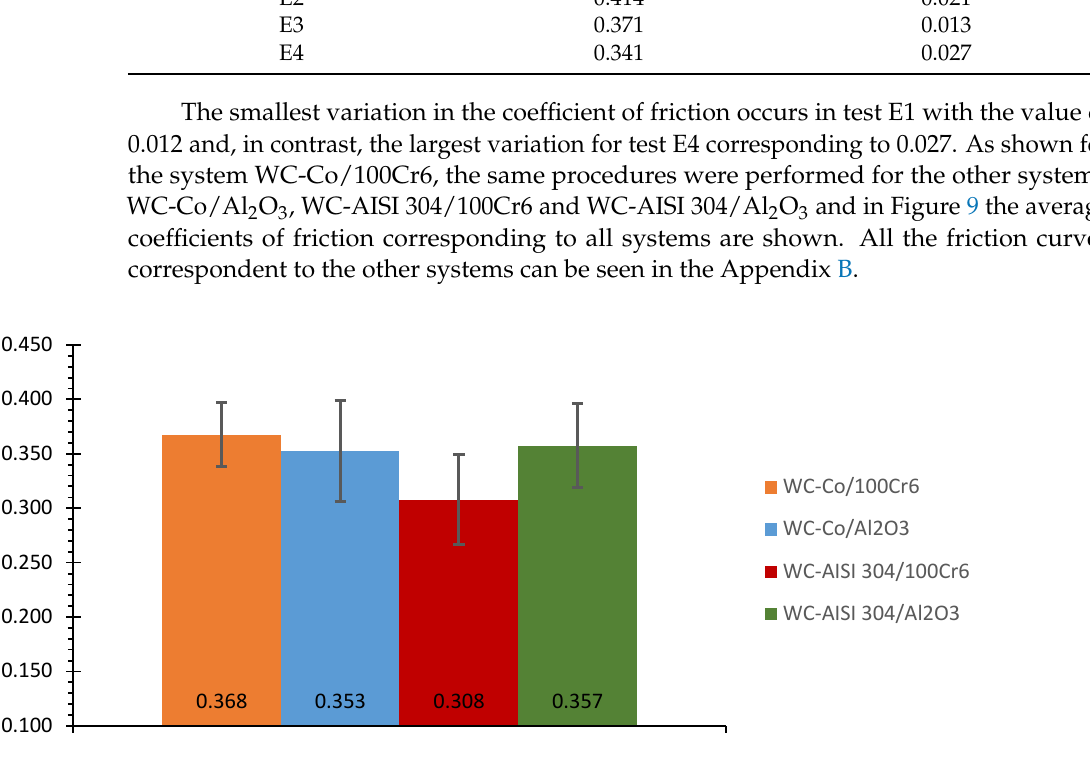
Table 6. Variation of coefficients of friction for the systems: WC-Co/100Cr6, WC-Co/ Al 2 O 3 , WC-AISI 304/100Cr6 and WC-AISI 304/ Al 2 O 3 .